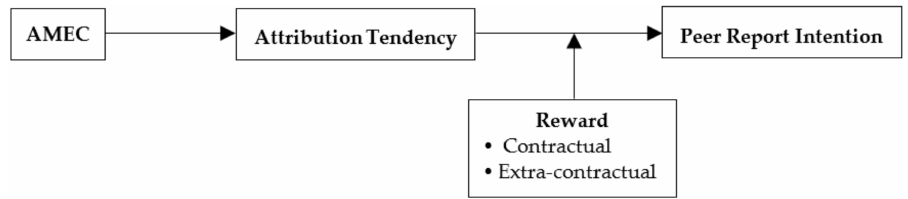
Figure 1. The research model (AMEC = adverse medical event